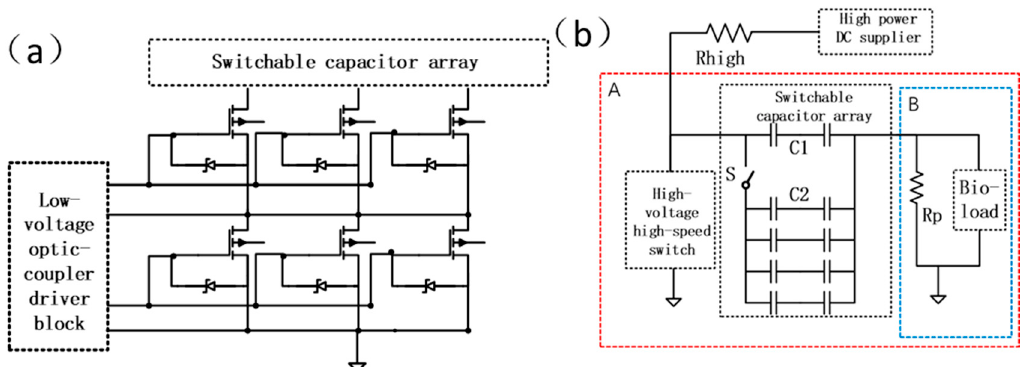
Figure 4. Schematic diagram of low-voltage optic-coupler driver block. Figure 5. Schematic diagram of ( a ) the high-voltage high-speed switch, and ( b ) switchable capacitor array and the operation of the pulse generator.